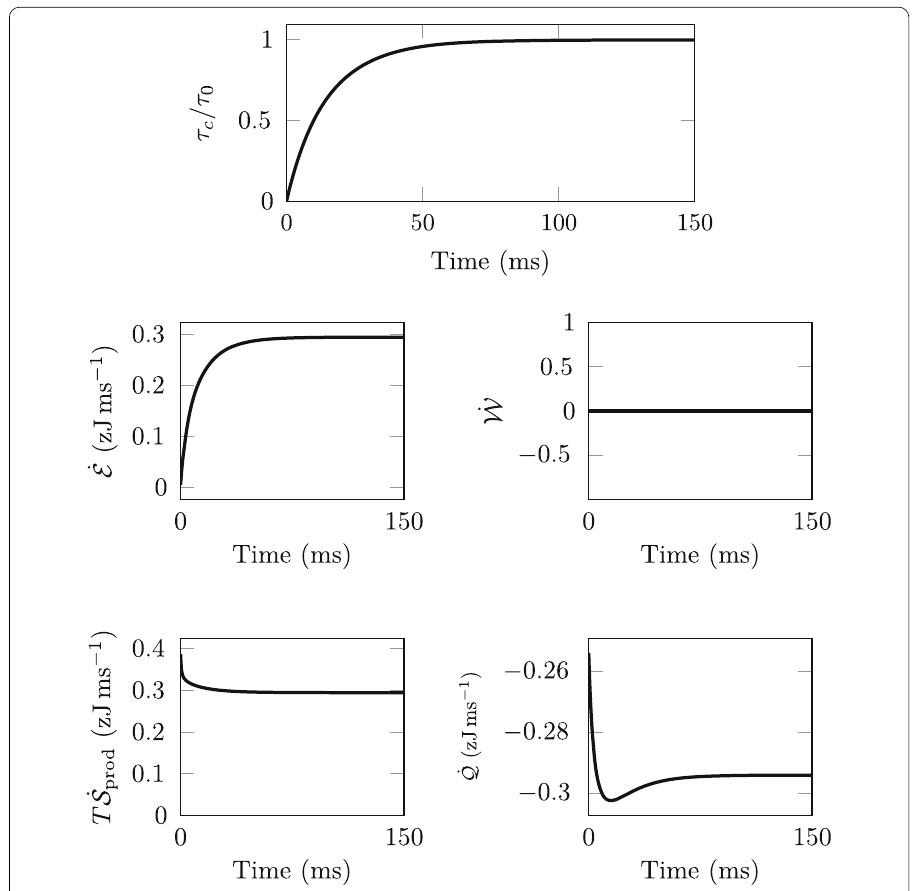
Fig. 9 Average tension and thermodynamic fluxes per myosin head in an isometric tension rise simulation with the Huxley’57 model. The isometric tension is denoted by τ 0